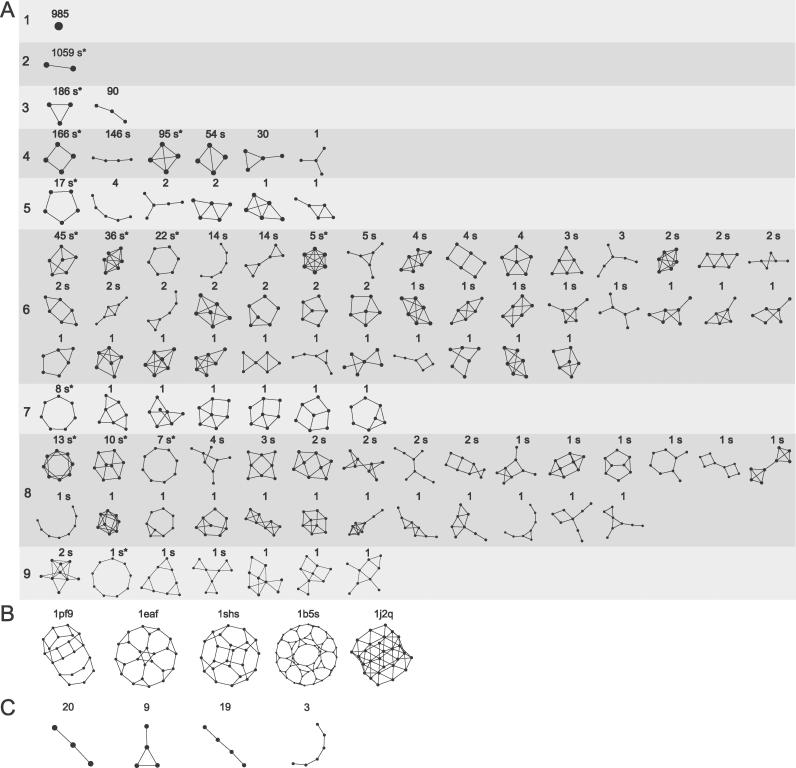
Examples of Quaternary Structure Topologies(A) All QSTs for complexes with up to nine subunits are shown, accounting for more than 96% of the nonredundant set of QSs and more than 98% of all complexes in PDB. Topologies compatible with a symmetrical complex are annotated with an s, and topologies where all subunits have the same number of interfaces (edges) are annotated by a star (*).(B) Examples of large complexes that are the single representatives of their respective topologies (QSTs). PDB codes are given. 1pf9, E. coli GroEL-GroES-ADP; 1eaf, synthetic construct, pyruvate dehydrogenase; 1shs, Methanococcus jannaschii small heat shock protein; 1b5s, Bacillus stearothermophilus dihydrolipoyl transacetylase; 1j2q, Archaeoglobus fulgidus 20S protesome alpha ring. It is interesting to note that the graph layouts resemble the spatial arrangements of the subunits.(C) Likely errors in the PDB Biological Units: QSTs of homomers with different numbers of contacts amongst the subunits. The number of erroneous QSs in each topology is provided above each graph.